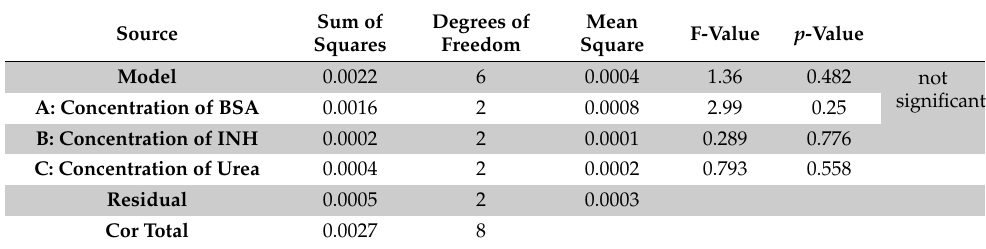
Table 4. ANOVA table for the polydispersity.